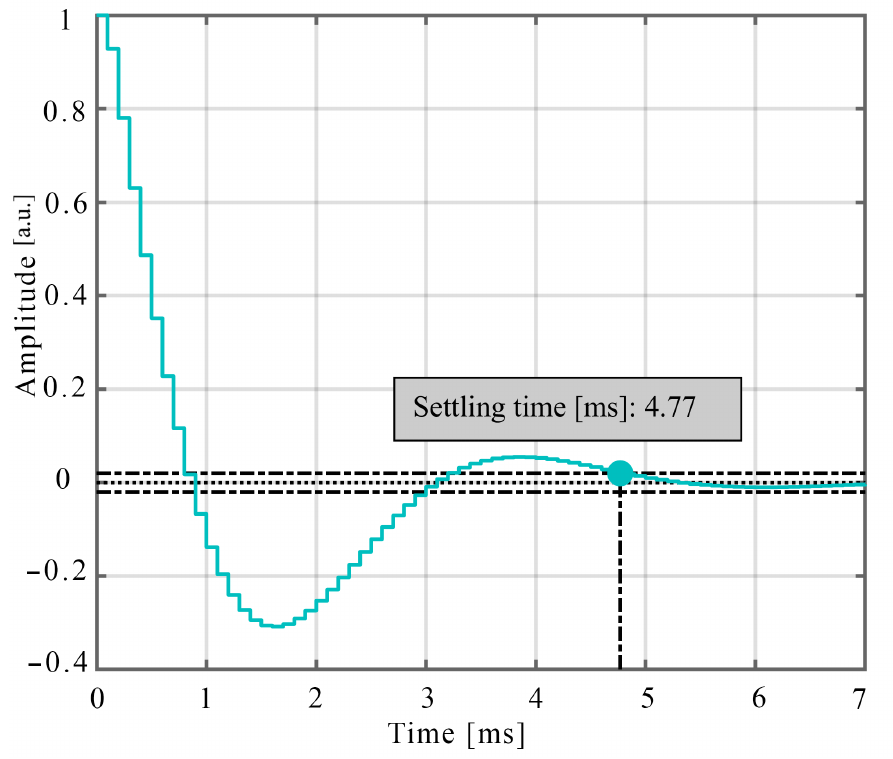
Figure 6. Voltage step rejection response estimated with